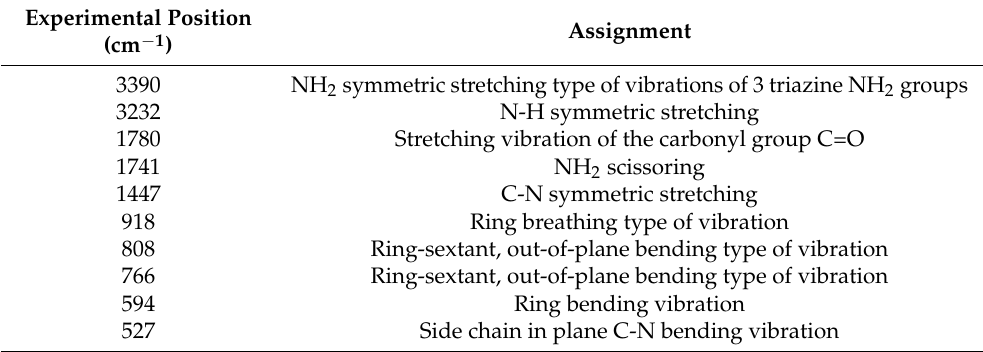
Table 1. Vibration bands’ assignment of the fire retardant.